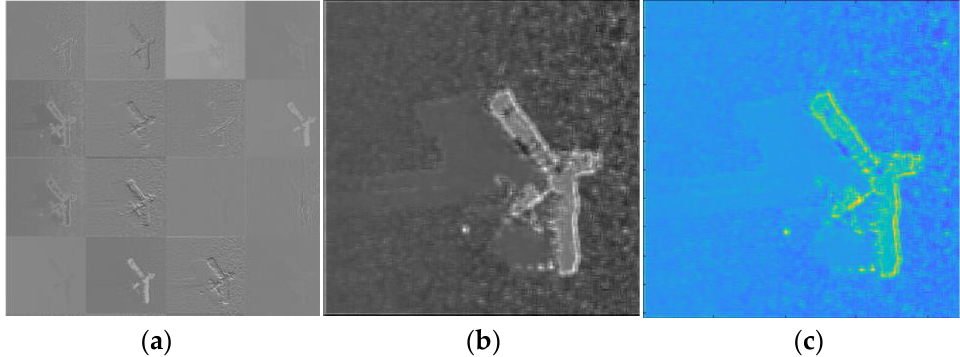
Figure 10. Feature response maps and that after staining: ( a ) Feature maps of the first 16 channels of